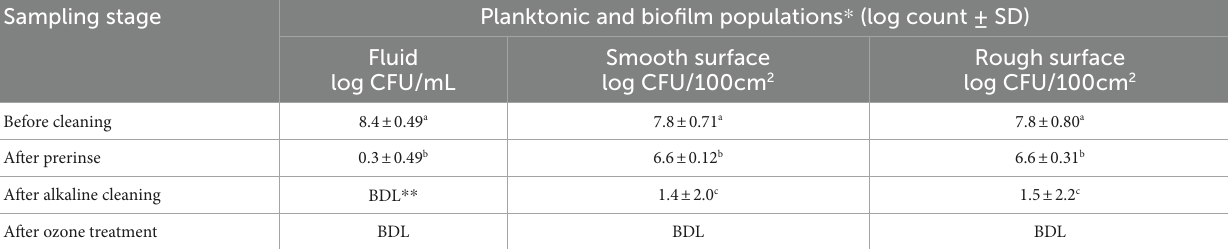
* Different superscripts, withing the same column, indicate significant differences between cleaning stages ( p < 0.05). ** Counts were below the detection level (0 log CFU/mL) of the enumeration method for fluid samples. TABLE 2 Pseudomonas fluorescens ATCC 25289 populations recovered from the CIP system that was contaminated with 10% skim milk, inoculated with 0.5% culture, and held for 2 days, followed by circulating 10% skim milk for 5 days. The biofilm was subjected to water prerinse, alkaline cleaning (0.2% for 2 min), water post-rinse, and ozone treatment (10 ppm for 10 min) . Population counts were determined in fluid samples (for planktonic cells) and swab samples (for biofilm cells); the latter were taken from smooth and rough surfaces after different stages of cleaning and sanitization.